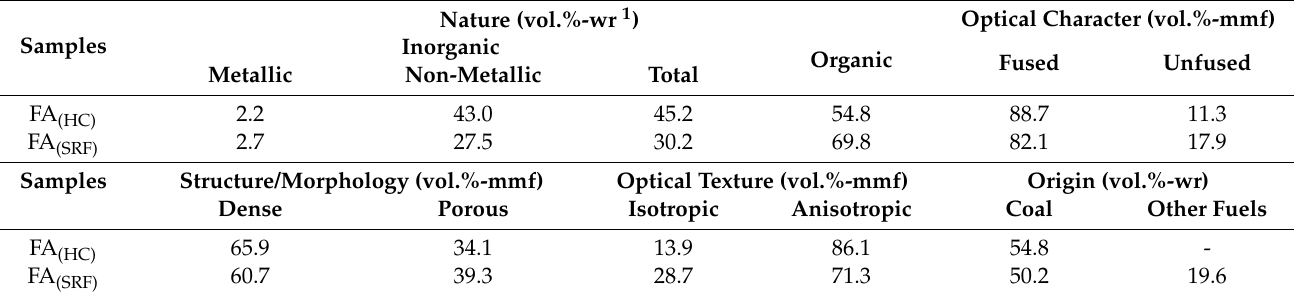
Table 4. Quantitative petrographical characterization of fly ash organic components (based on [21]).